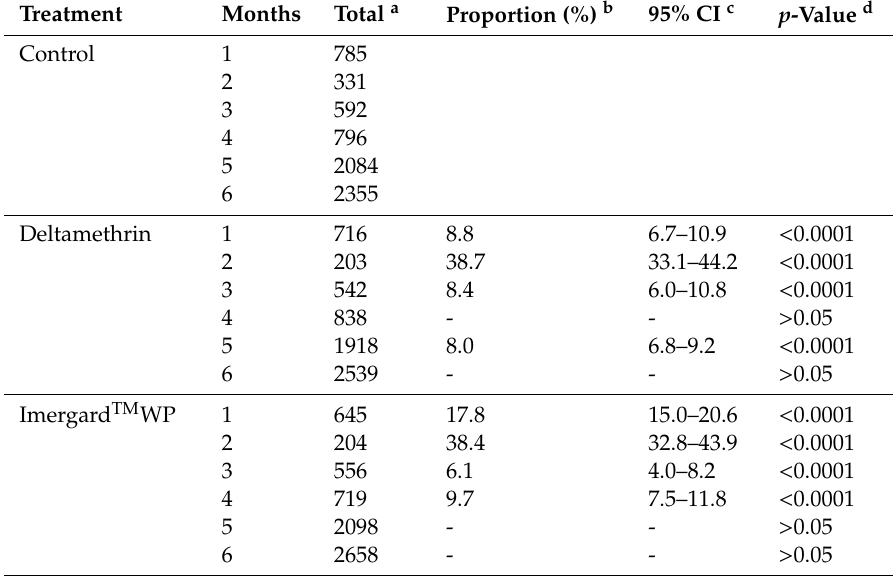
Table 1. Hut entry reduction in wild-type Anopheles gambiae